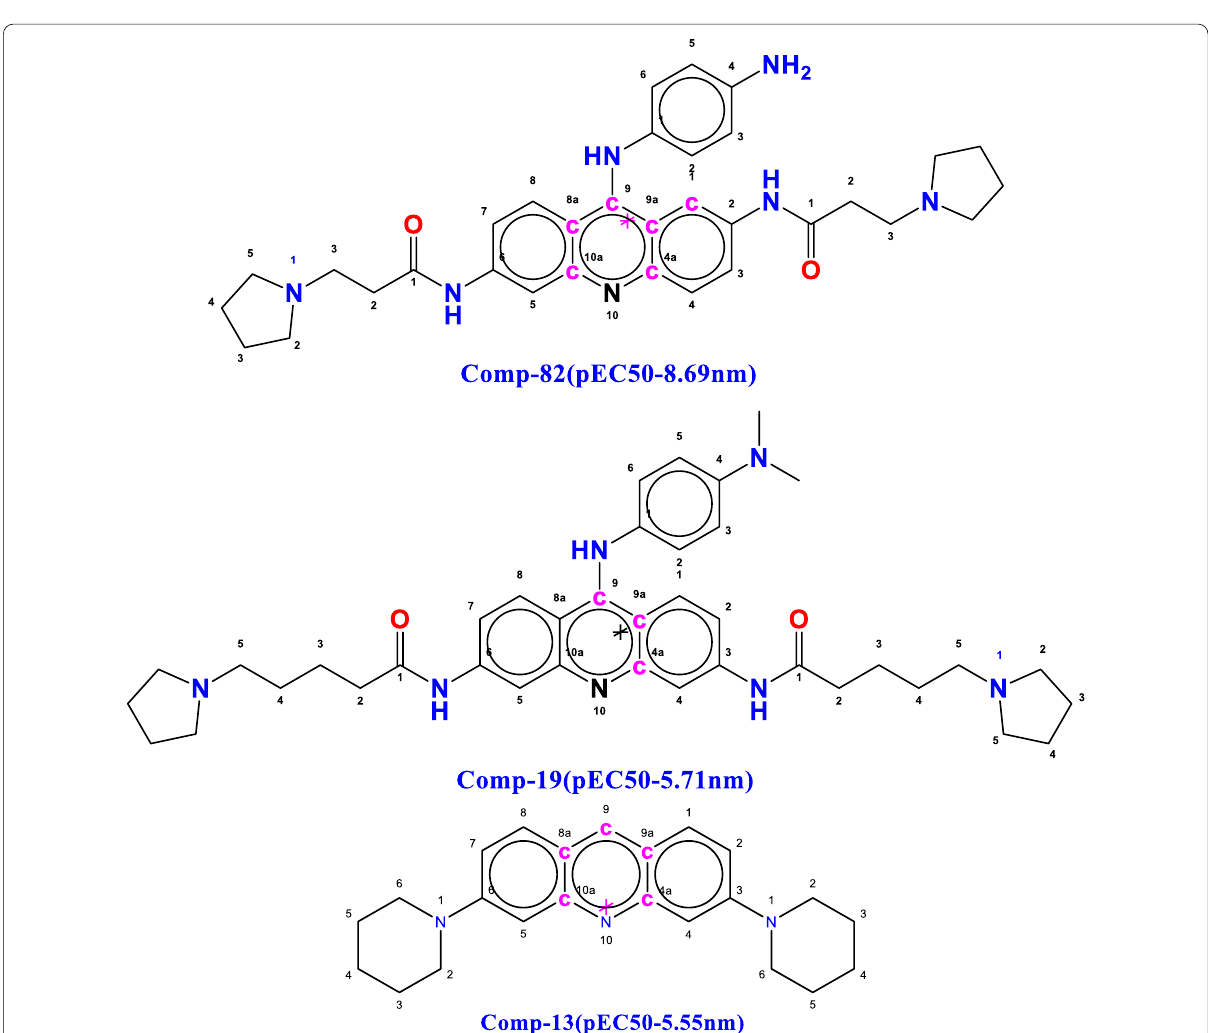
Fig. 9 Depiction of descriptor com_aroC_2A (occurrence of aromatic carbon atom within 2 A from center of mass of molecule, carbon atoms highlighted in bold pink color are present within 2 2 A 0 from the center of